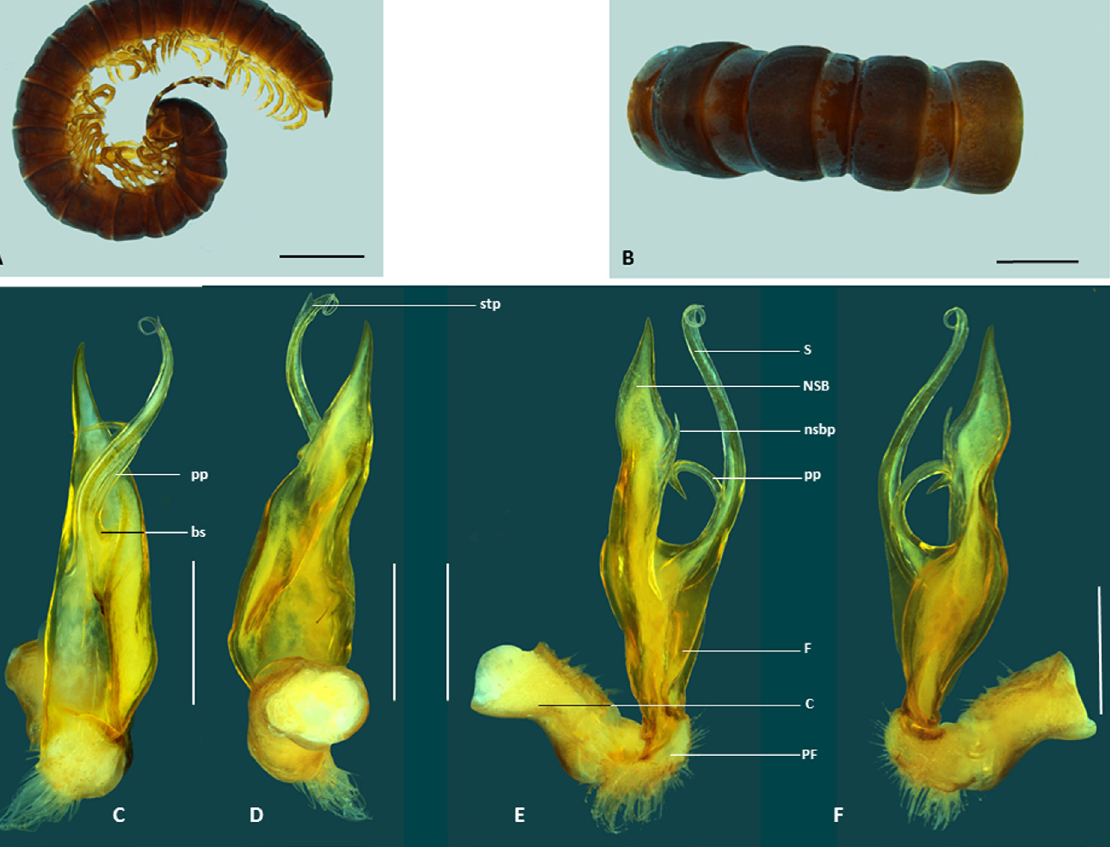
Fig. 4. Boreohesperus vascellus sp. nov. A . Paratype, ♂, habitus (WAM T73954). B . Holotype, ♂, habitus (WAM T137095). A . Lateral view. B . Dorsal view. C, E–F . Paratype, ♂, left gonopod (WAM T73954). D . Holotype, ♂, left gonopod (WAM T137095). C . Posterior view. D . Anterior view. E . Medial view. F . Lateral view. Abbreviations: bs = solenomere base; C = coxa; F = femorite; NSB = non- seminiferous branch; nsbp = non-seminiferous branch process; PF = prefemur; pp = posterior